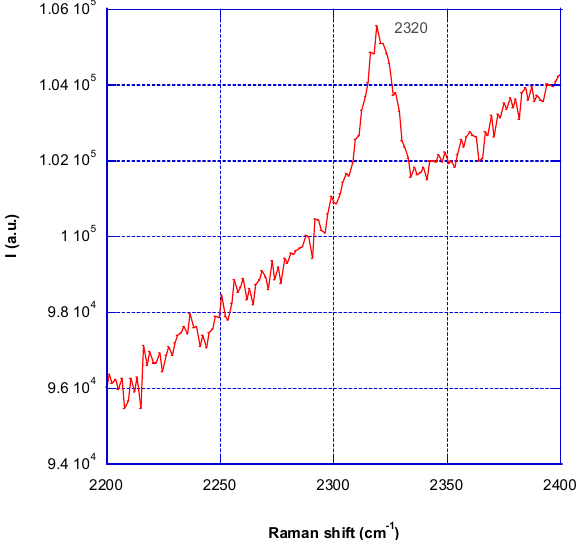
Figure 3. Micro-Raman spectrum of AlN pre , peak of the nitrogen multiple bonds in the region (2200–2400 cm − 1 ).